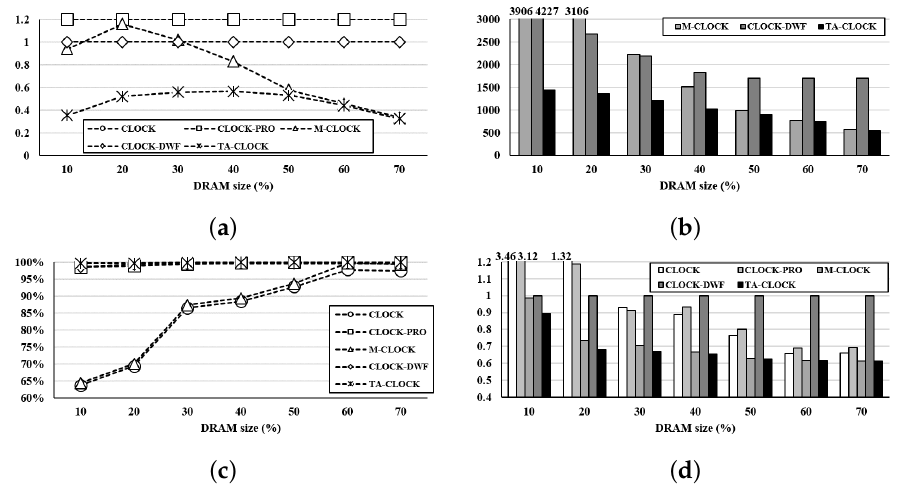
Figure 11. Average results of all workloads. ( a ) Normalized write operations in the PCM; ( b ) Number of migrations between DRAM and PCM; ( c ) The hit ratio of write operations in DRAM; ( d ) Normalized energy delay